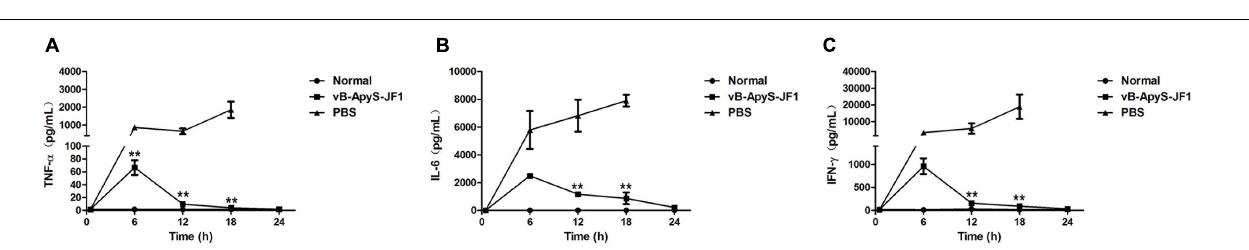
FIGURE 9 | Levels of TNF- α , IL-6, and IFN- γ in the blood of mice. All mice were from three groups: phage (vB-ApyS-JF1) treatment group (mice were injected with T. pyogenes BS, and phage JF1 was administered 30 min after challenge in a single dose); PBS treatment group (mice were injected intraperitoneally with T. pyogenes BS, and PBS was administered 30 min after challenge). The normal group without any treatment was used as a control. Three mice from each group were euthanized at each time point. Blood samples were collected from mice of each group 6, 12, 18, and 24 h after challenge. The levels of TNF- α (A) , IL-6 (B) , and IFN- γ (C) cytokines in the blood were measured. Blood samples from healthy mice were used as controls (normal group). The values represent the means and SDs ( n = 3). ** P <